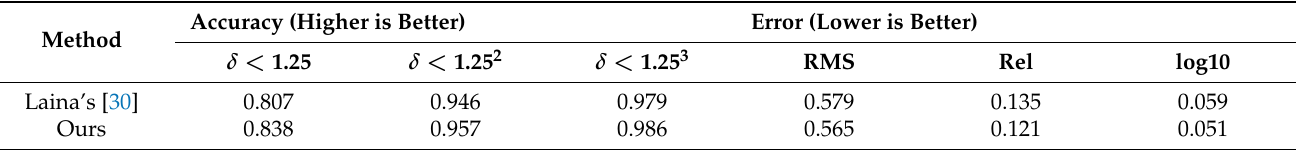
Table 6. Comparison of experimental results on depth estimation.